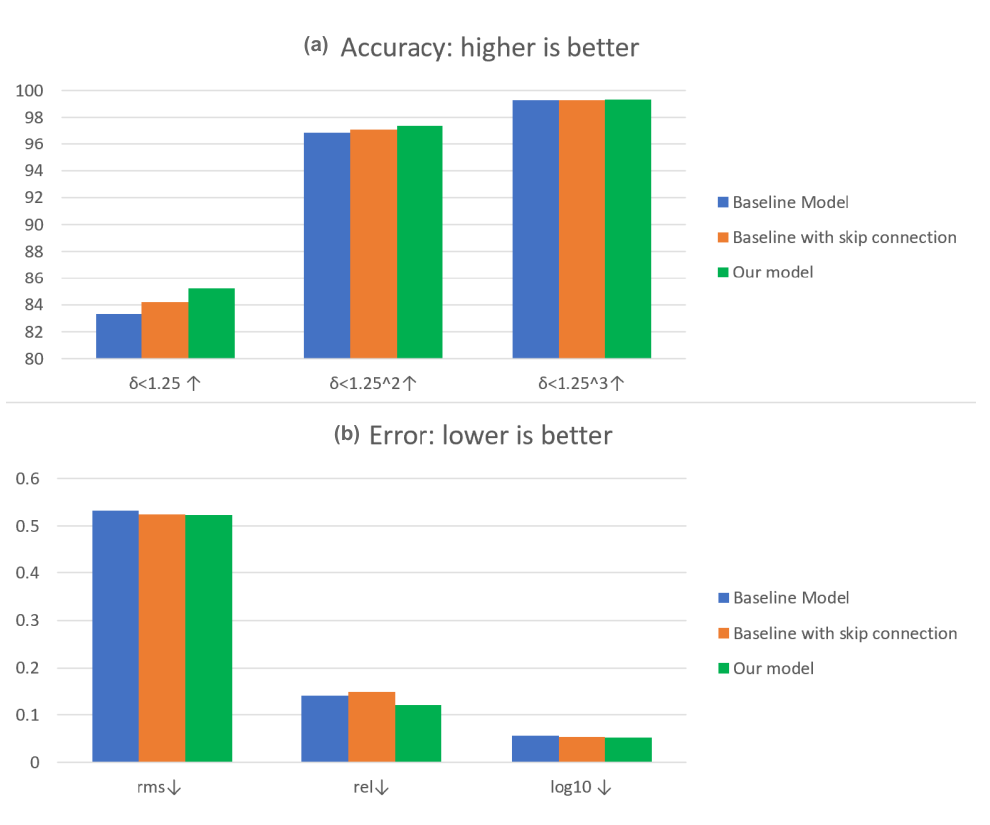
Figure 4. ( a ) The accuracy and ( b ) the three error measures of the three variations of our model with the NYU Depth-v2 dataset (green); baseline (blue), and baseline with skip connection (orange). Table 2. Quantitative results of the ablation study on the SUN RGB-D dataset without fine-tuning. Accuracy: Higher Is Method